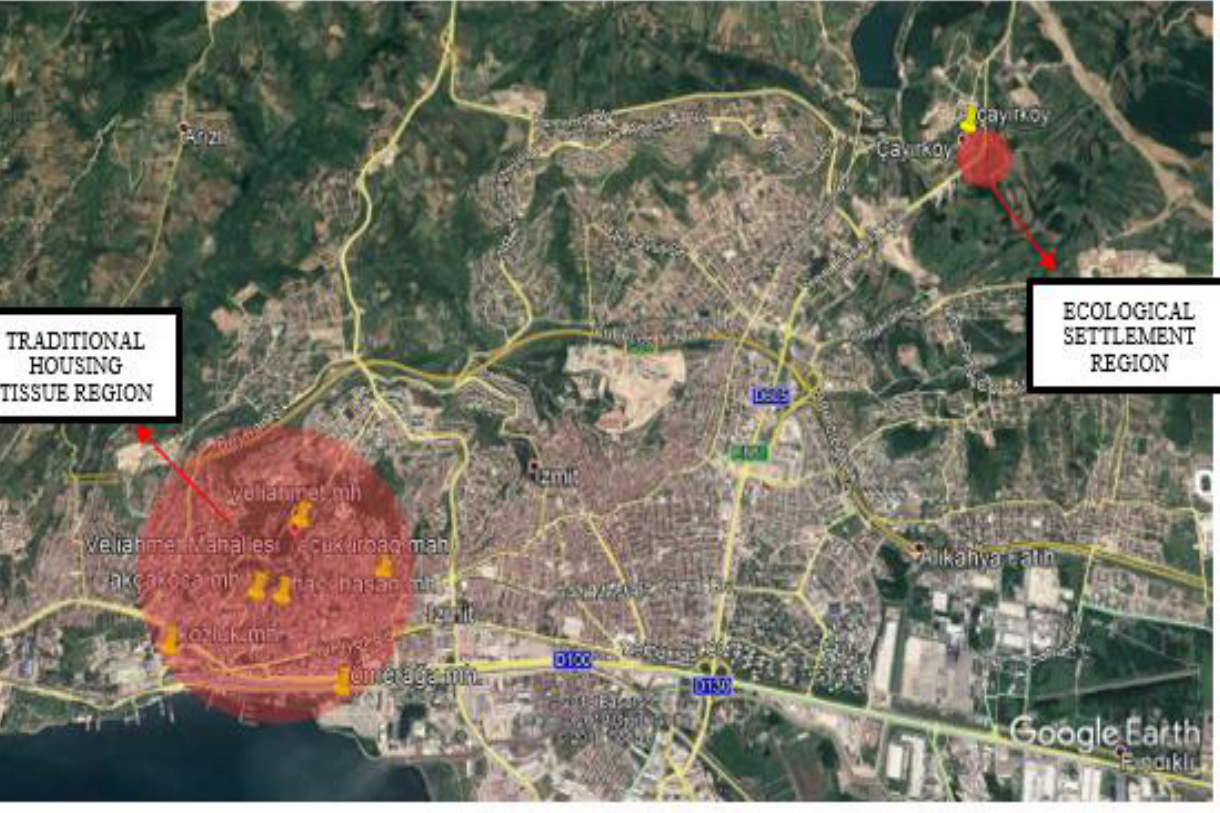
Figure 5. Kocaeli traditional texture and ecological settlement